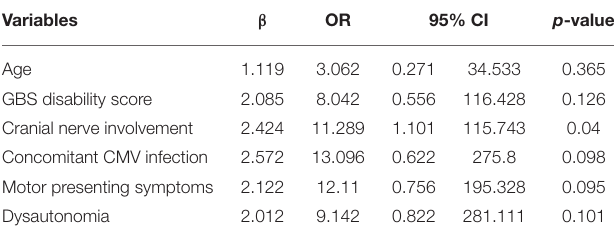
TABLE 4 | Multivariable logistic regression model for variables associated with ICU